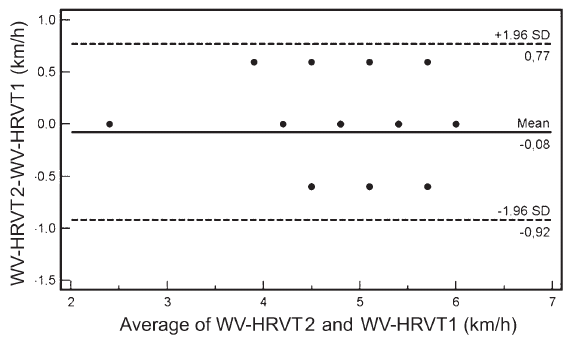
Figure 1. Agreement between walking velocity (WV) at heart rate variability threshold (HRVT) obtained in the 1st (WV-HRVT1) and 2nd (WV-HRVT2) incremental shuttle walk tests.